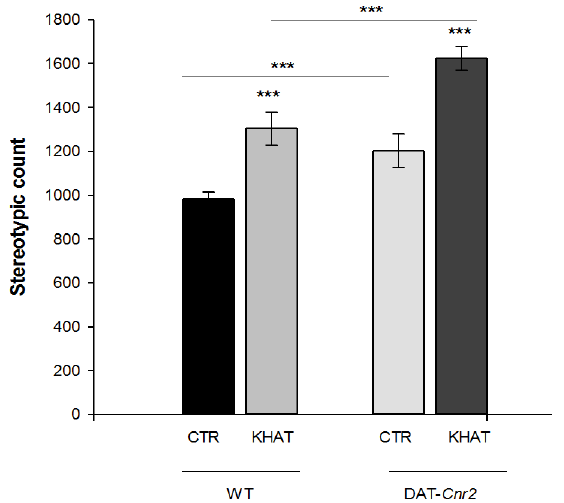
Figure 2. Sub-acute effect of khat extract on stereotypic count in the activity monitor apparatus in wild type (WT) and DAT- Cnr2 mice. Values are mean ± SEM (n = 6 in each group). Statistical analysis was done using student t -test. *** p < 0.001. CTR (control group received the vehicle), KHAT (treatment group received khat extract in a dose of 300 mg/kg). The vehicle and khat extract were administered to mice once daily for seven consecutive days.